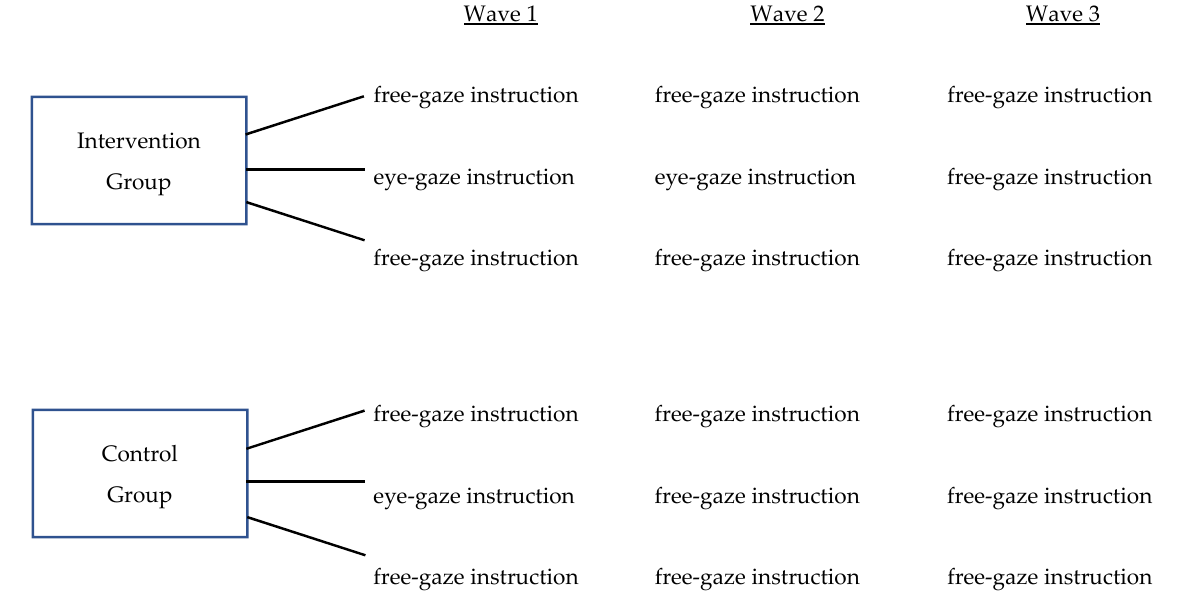
Figure 5. Summary of blocks of FACES task. Note: FACES = The University of New South Wales (UNSW) Facial Emotion